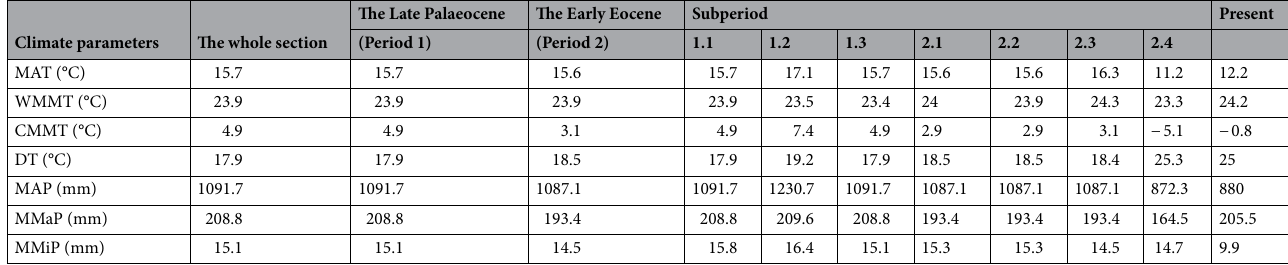
Table 3. Comparison of climate parameters from the Late Palaeocene to Early Eocene in Luanchuan with those of the present 22 based on the median value of each climate